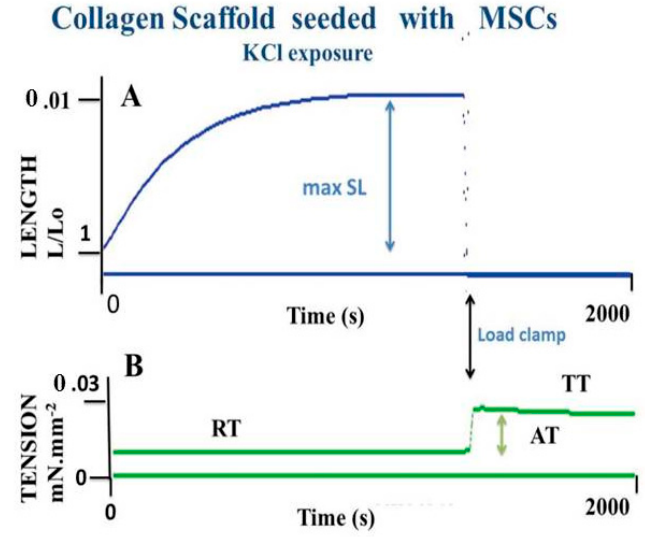
Figure 4. Basic contractility of an MSC-seeded collagen scaffold . Effect of 0.05 M KCl on a MSC-laden collagen scaffold. Panel A : scaffold shortening. Panel B : tension generation. When the collagen scaffold reaches a plateau, shortening length reaches a maximum (maxSL). The black arrow marks the time at which tension is suddenly increased, placing the collagen scaffold under isometric conditions. Active tension (AT) is the difference between total isometric tension (TT) and resting passive tension (RT).